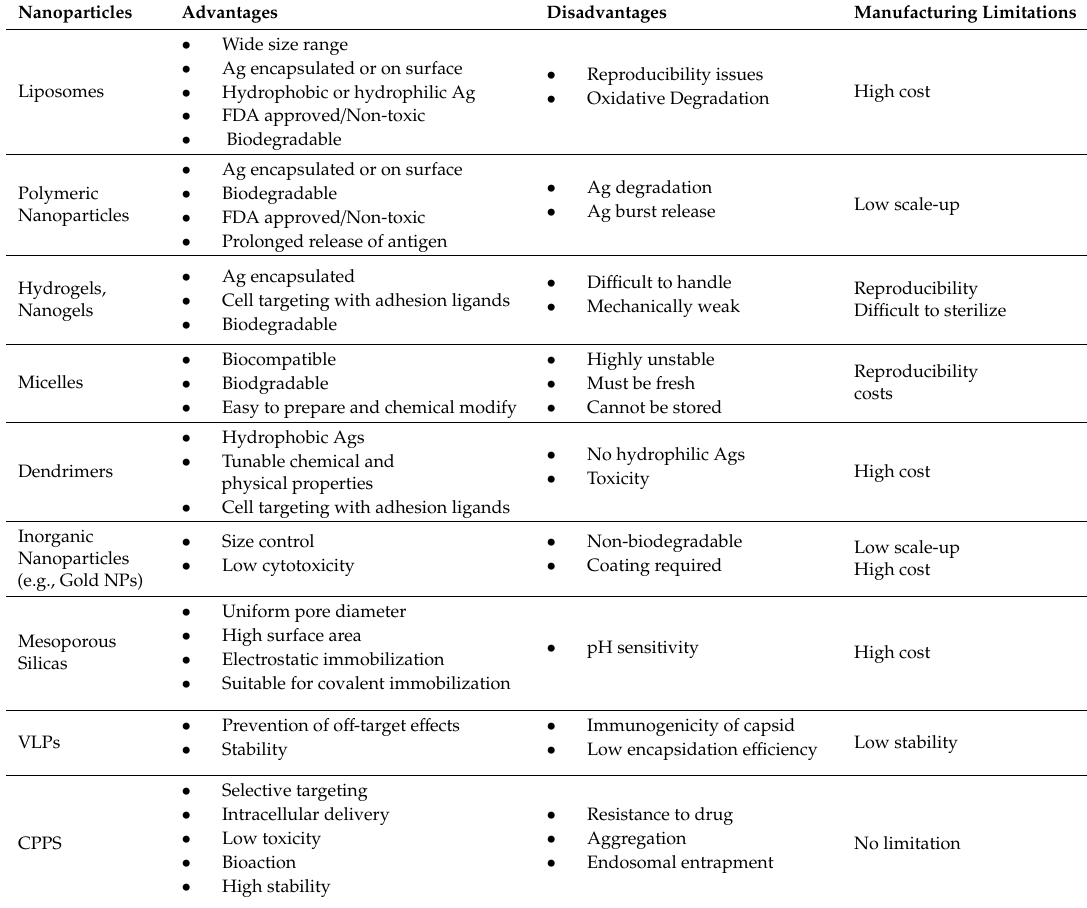
Table 3. Biological, chemical and manufacturing characteristics of